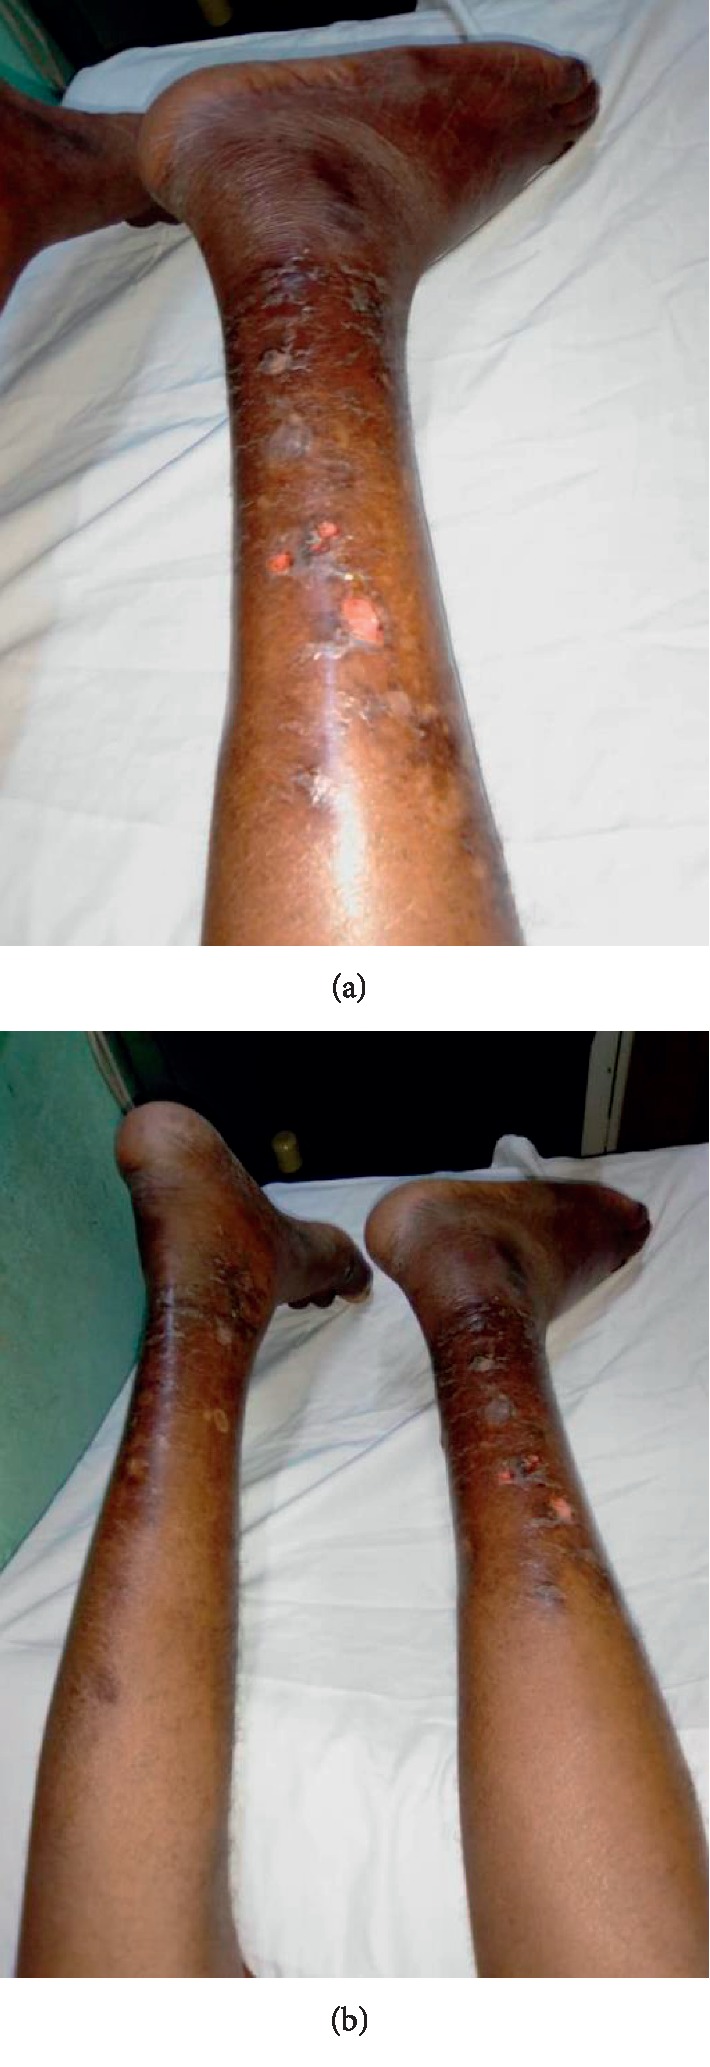
Skin xerosis complicated by postscarring ulcerations in chronic hemodialysis.